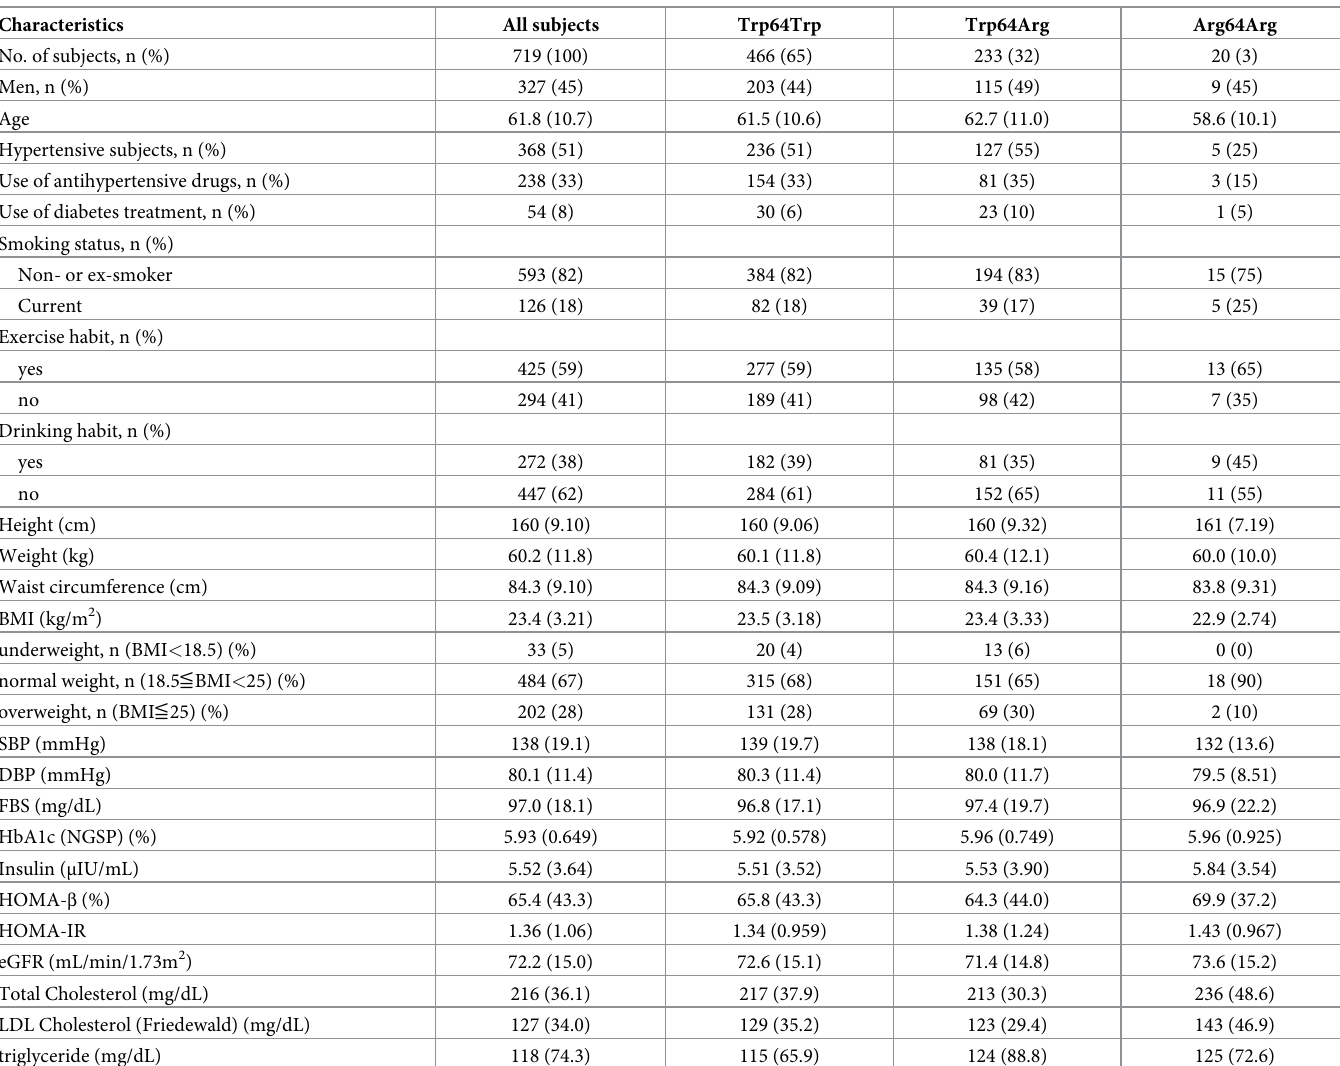
Table 1. Subject characteristics in three different allele